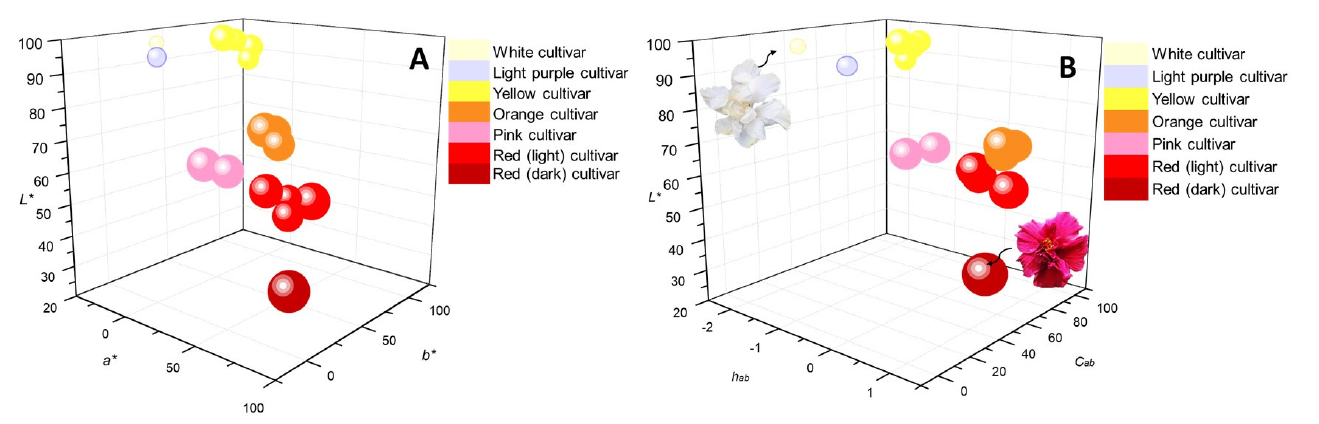
Figure 4. Three-dimensional bubble scatter graph represented with a color scale that corresponds to the floral extracts of H. rosa-sinensis studied, according to the CIELAB colorimetric parameters: ( A ). L* , a* , b and ( B ). L* , Cab , hab . The bubble sizes are proportional to the value of the antioxidant activity, measured by the ORAC method.